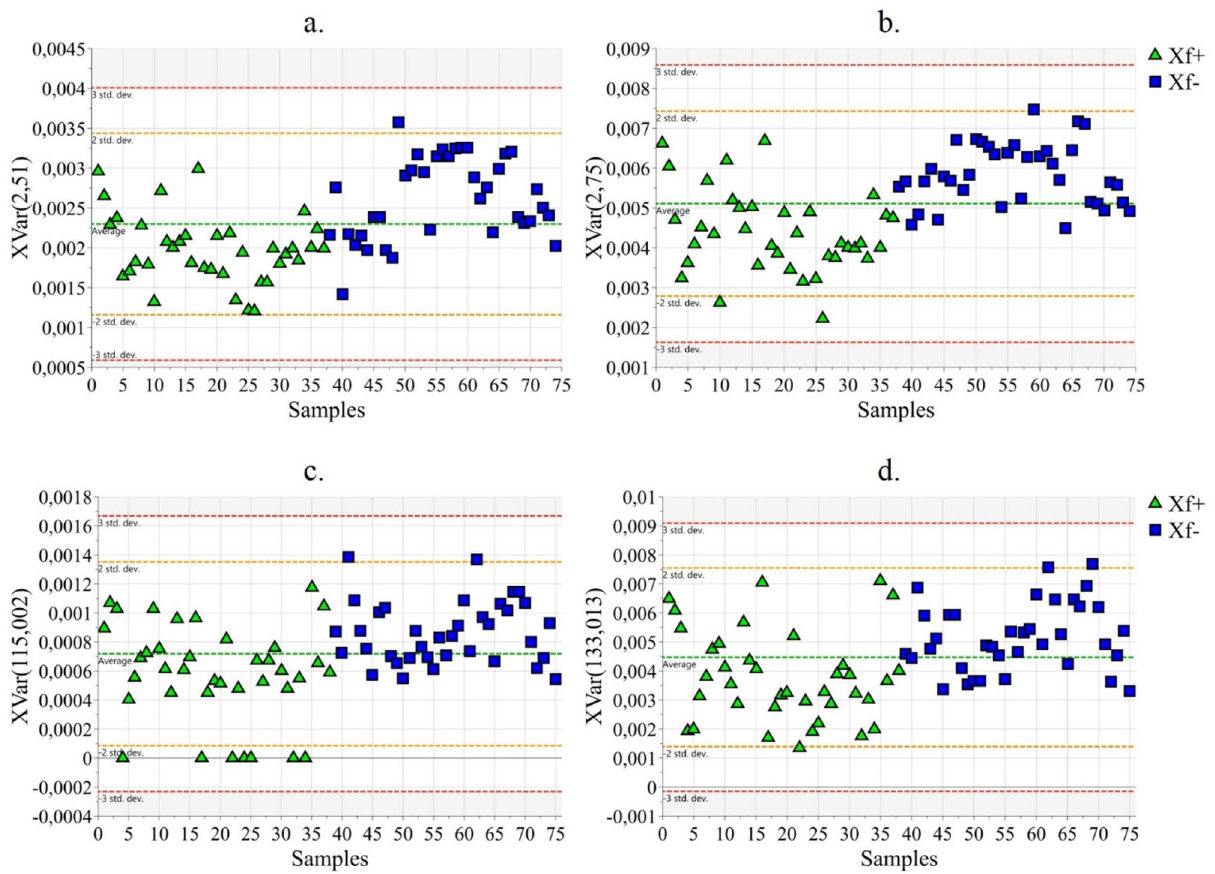
Figure 4. Statistic of the buckets attributable to malic acid [( a ) 2.51 ppm; ( b ) 2.75 ppm; ( c ) 115.002 m/z; ( d ) 133.013 m/z]; Xf+: samples from X. fastidiosa inoculated plants; Xf−: samples from X. fastidiosa non-inoculated